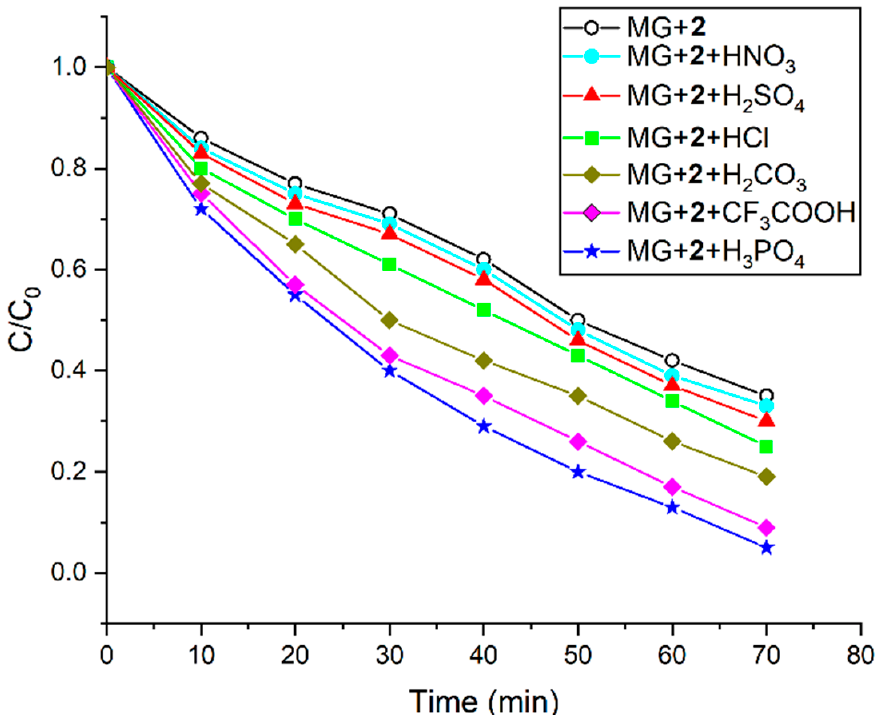
Figure 9. Photocatalytic degradation of the MG dye in aqueous solution (pH 7, temperature 298 K) under visible light irradiation by photocatalysts generated from compound 2 with various acids. In contrast, the observed degradation rate of MG was 65% for compound 2 and 67, 70, 75, 80, 91, and 95% for the photocatalysts derived from compound 2 with HNO 3 , H 2 SO 4 , HCl, H 2 CO 3 , CF 3 COOH, and H 3 PO 4 , respectively (Figure 9). From the above